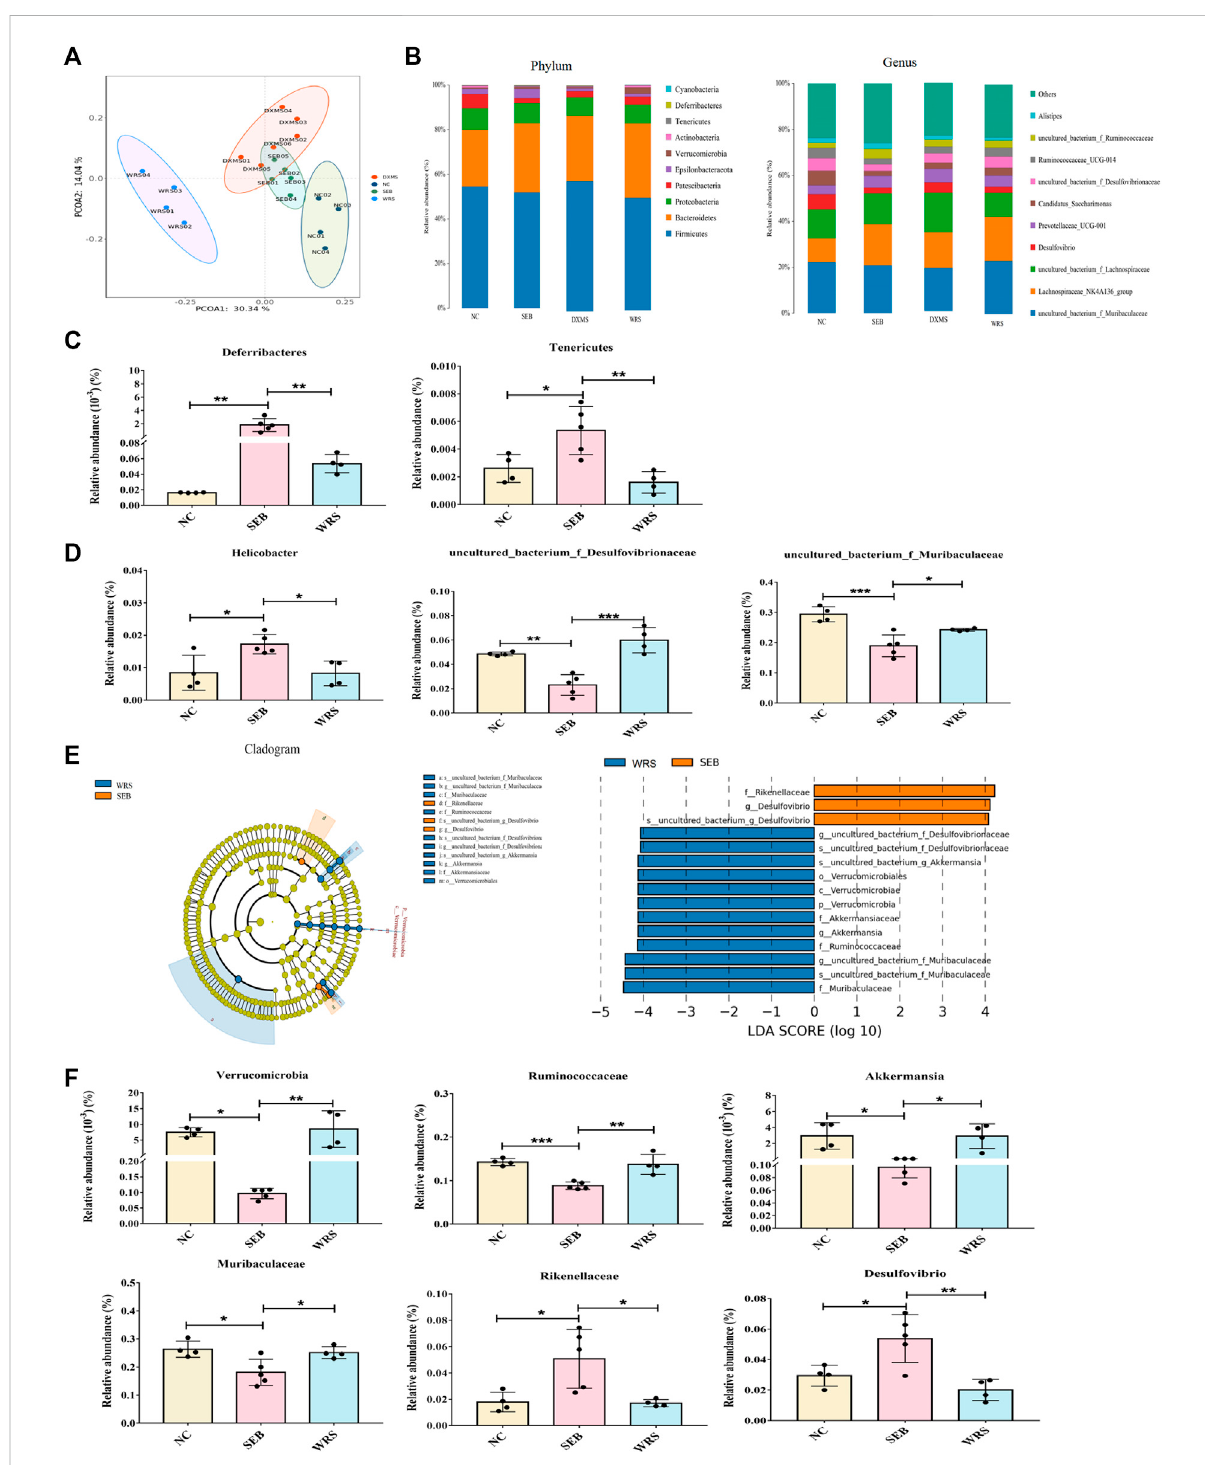
FIGURE 2 WRS altered the gut microbiota community composition of mice with SEB infection. (A) Principal co-ordinator analysis. (B) Top 10 most abundant bacterial atthe phylum level and genuslevel. (C,D) Representative histogram of the gut microbiota at thephylum level and genus level. (E) LEfSe and cladogram analysis. (F) Relative abundance of key bacterial. Data have been presented as means ± SD ( n = 4 – 6). Statistical analysis was carried out using one-way ANOVA. * p < 0.05, ** p < 0.01, *** p < 0.001.